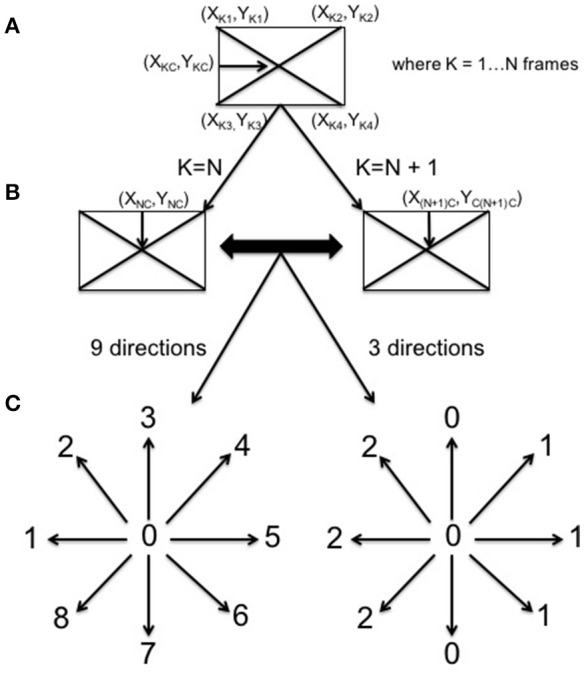
Categorization of movement. The central coordinates of the TLD window are extracted (A) and compared to the next window central coordinates (B). The movement was classified following two systems of coordinates containing 9 and 3 categories of movement directions, respectively (C).